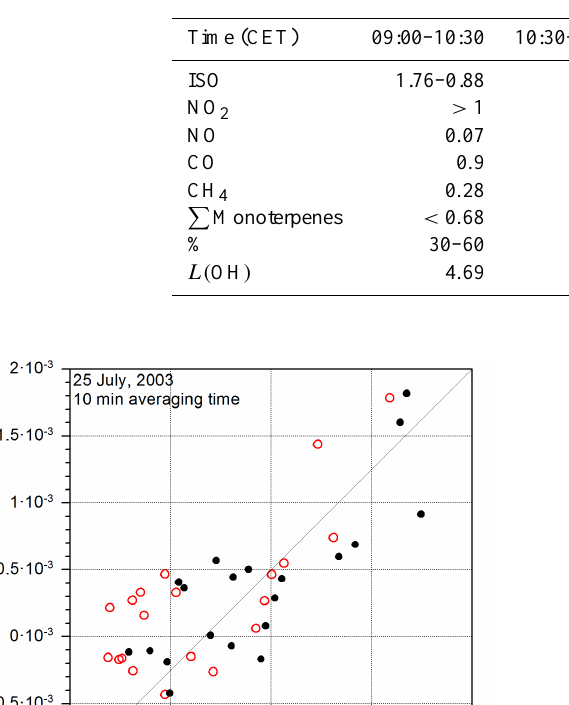
Table 2. Mean reaction rates [s − 1 ] for different reactants, the total OH loss L( OH ) [ s − 1 ] , the OH reactivity and the percentage of OH reacting related to isoprene for 25 July 2003 at the ECHO site.